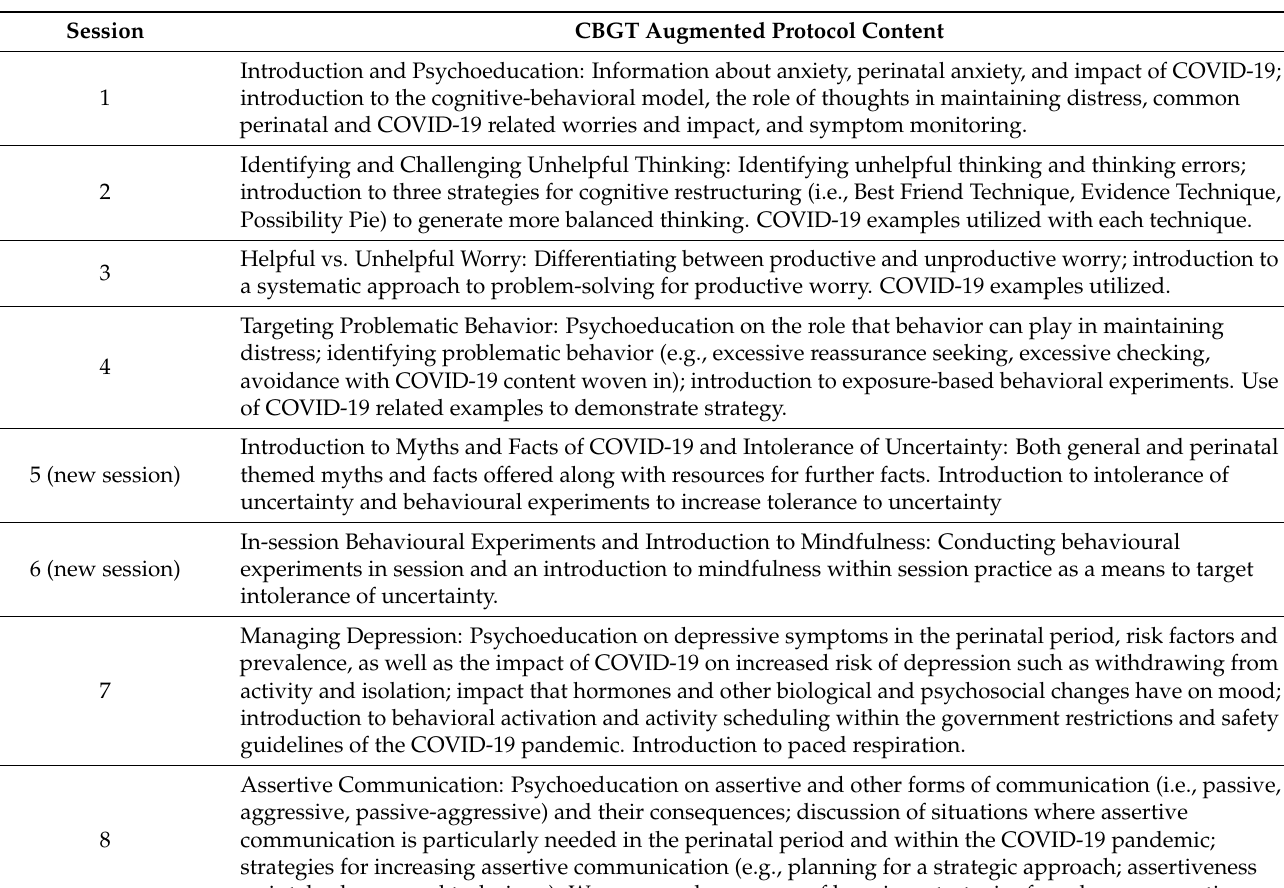
Table 2. Augmented 8-week CBGT protocol session by session